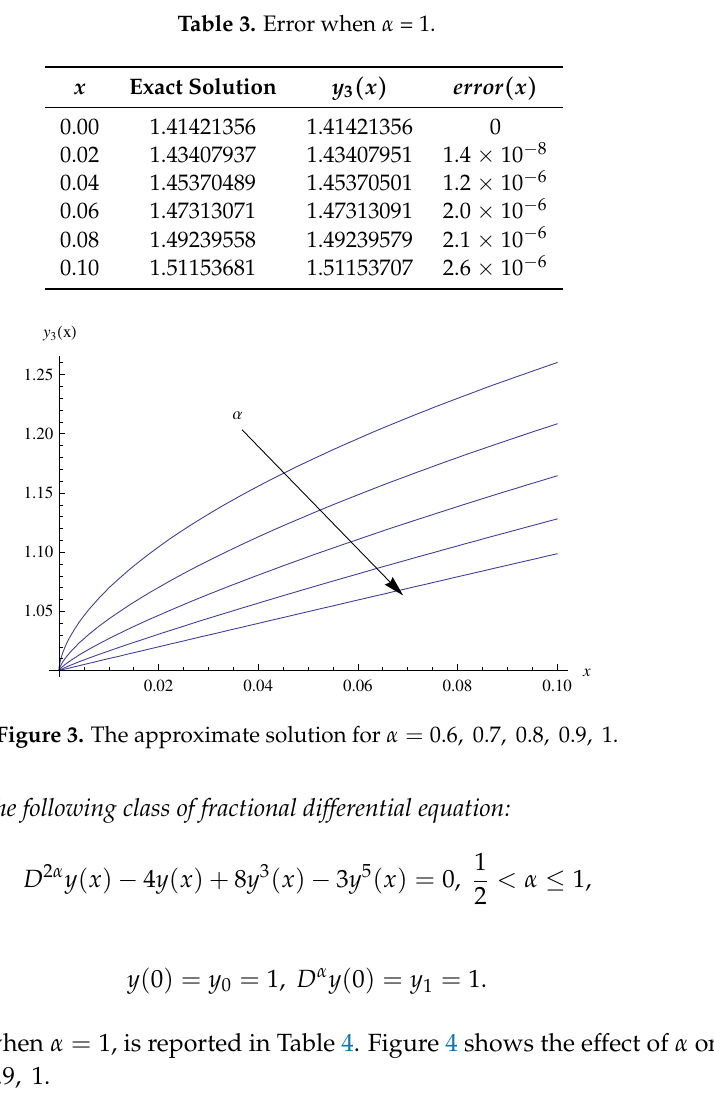
Table 4. Error when α =